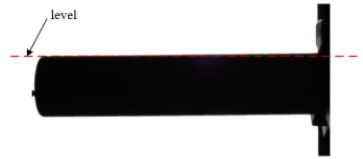
Figure 14. Original workpiece image.